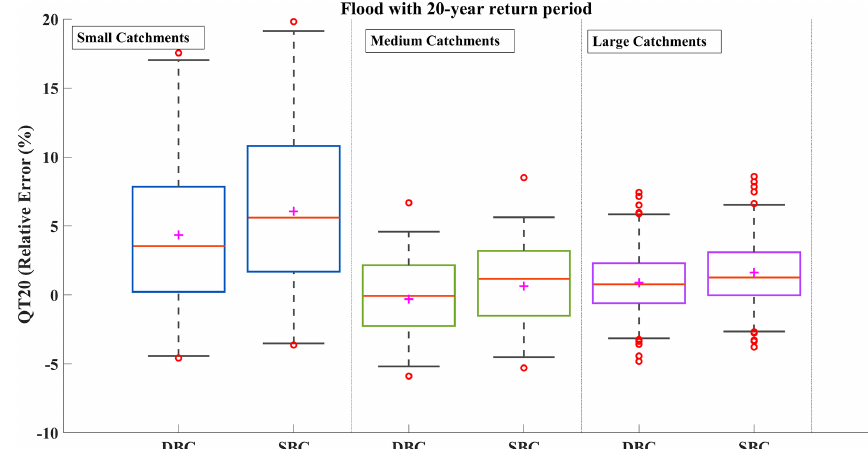
Figure 9. Distribution of the relative error ((model-obs) / obs × 100%) for the 20 year flood QT20. Boxplots for both bias-correction methods (DBC and SBC) are constructed from the distribution of relative errors from all catchments within each size class (small, medium, and large).